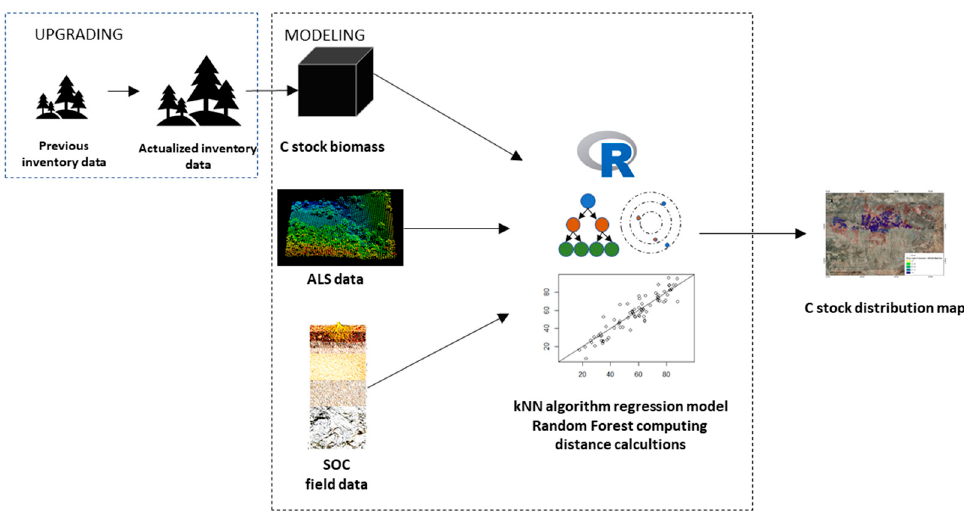
Figure 1. Flowchart describing the methodological steps to derive C-stock distribution maps for the species Pinus halepensis, P. pinaster, P. nigra , and P. sylvestris in Sierra de los Filabres from historical field data inventory plots, airborne laser scanning (ALS) metrics and soil organic carbon (SOC) field data.